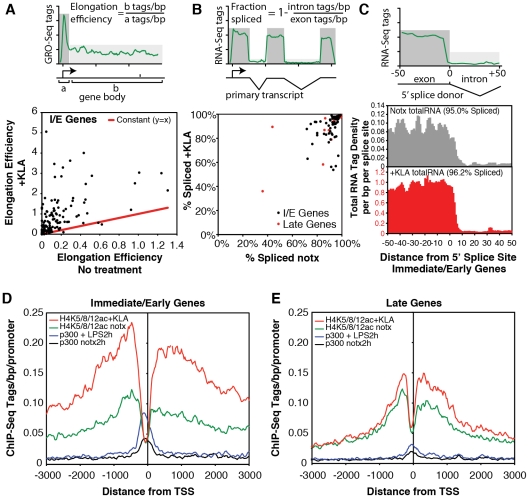
Quantification of elongation, splicing, and H4 actylation at I/E and late TLR4-responsive promoters.A. Gene-specific comparison of the elongation efficiency between control and KLA at 1 h treated samples for I/E genes. Elongation efficiency was defined as the ratio of strand-specific GRO-Seq tag density found within the gene body (+500 to +2500 bp downstream of the TSS) to the GRO-Seq tag density found at the proximal promoter (−25 bp to +175 bp). B. Gene-specific comparison of splicing efficiency between control and KLA treated total RNA-Seq samples at 1 h for I/E genes. Splicing efficiency was defined as one minus the ratio of intron RNA-Seq tag density divided by the exon RNA-Seq tag density for each gene. Only genes with intron and exon tag densities exceeding 1 read per kb were used included in this analysis. C. Visualization of tag-densities mapping across 5′ splice junctions in I/E genes. The density of the 3′ ends of total RNA-Seq tags (32 bp in length) are plotted relative to all RefSeq defined 5′ splice junctions in I/E genes. Splicing efficiency was estimated as one minus the ratio of the density of tags confidently mapping across the splice junction (3′ end from from +7 bp to +25 bp) by the density found in the exons (3′ end from −25 bp to −7 bp). D, E. Distribution of H4ac (composed of H4K5ac/H4K8ac/H4K12ac) and p300 at I/E and late genes.